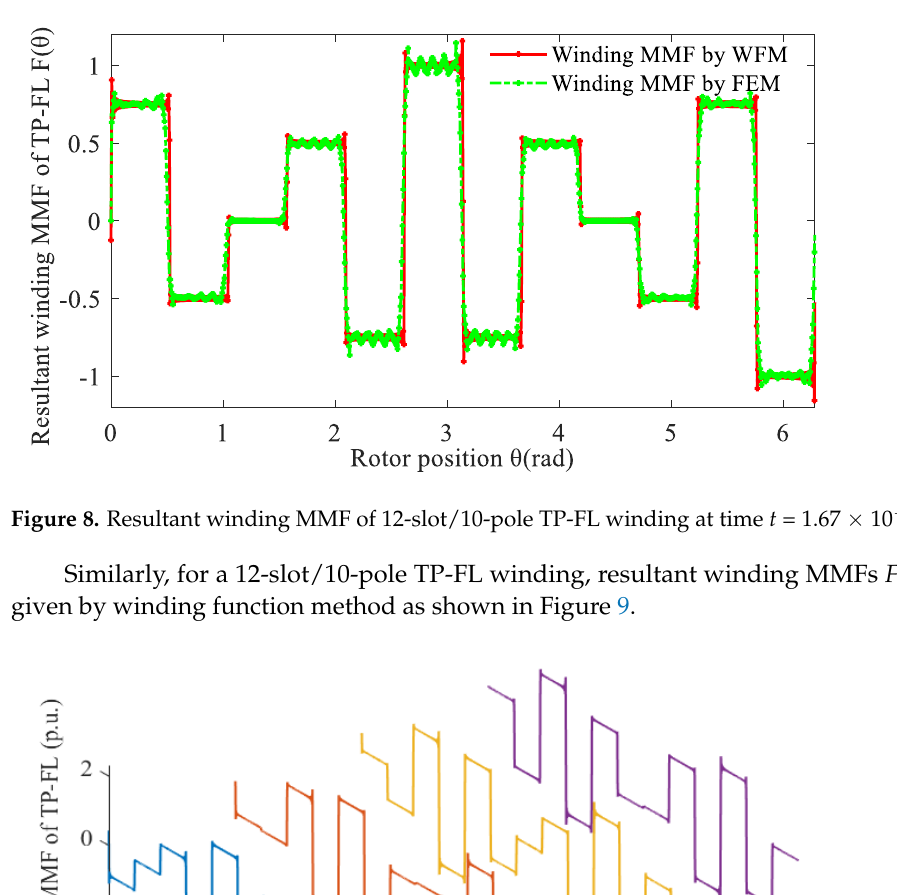
Resultant winding MMF of a TP-FL winding can be considered as a combination of two groups of three-phase double-layer (TP-DL) winding. When time t equals 1.667 × 10 − 3 s, the normalized values of phase current are equal to i A = 0.5 A, i B = 0.5 A, i C = − 1 A. Resultant winding MMF curve of TP-FL winding is also validated by the FEM as shown in Figure 8.